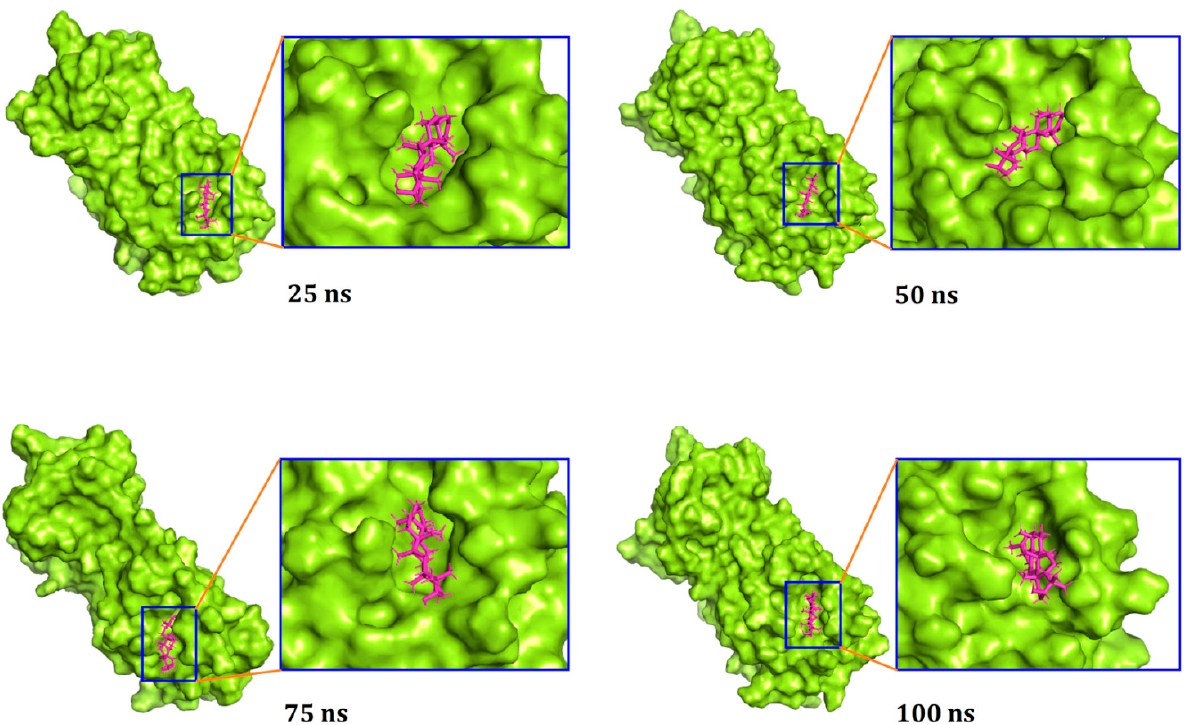
Figure 5. Surface views for the docked complex in the molecular dynamics simulation. The snapshots were taken at 25, 50, 75, and 100 ns, respectively, for (+)-epicatechin-3-O-gallate and the M pro complex.